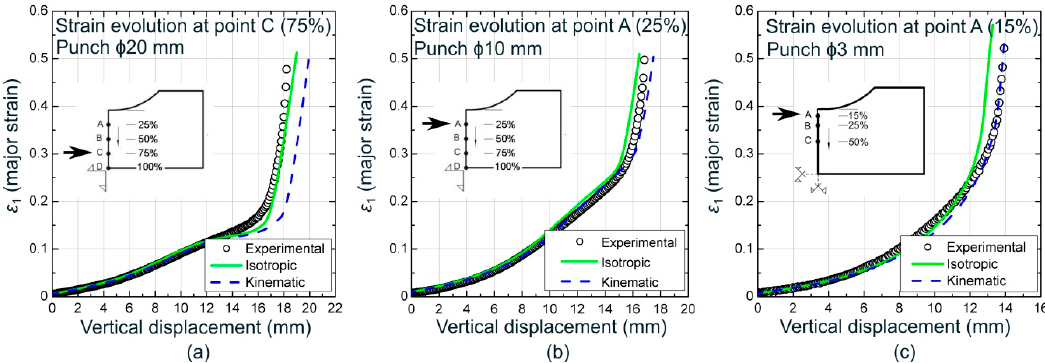
Figure 9. Experimental and numerical prediction of major strain at the outer surface versus vertical displacement for cylindrical punches of ( a ) φ 20 mm, ( b ) φ 10 mm, and ( c ) φ 3 mm (one quarter model).